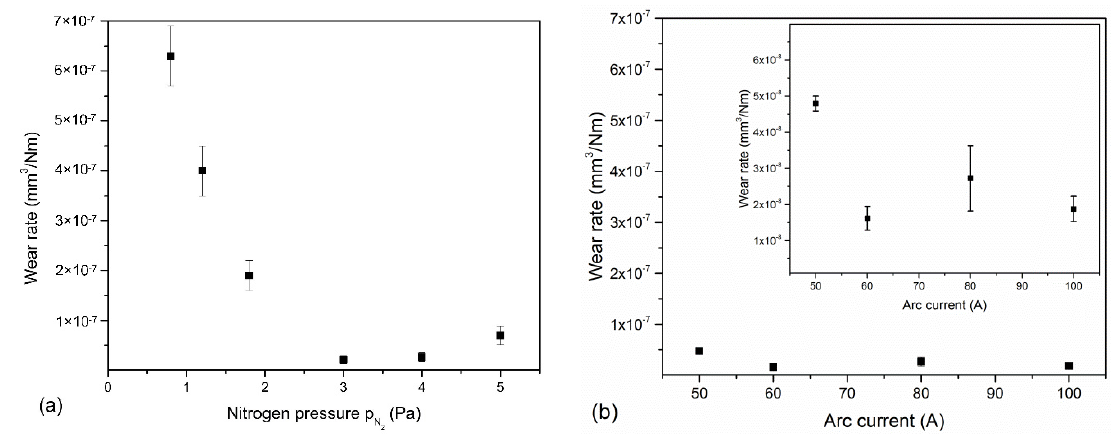
Figure 12. Wear rate of AlCrN coatings formed at: ( a ) various nitrogen pressure, ( b ) various arc current.